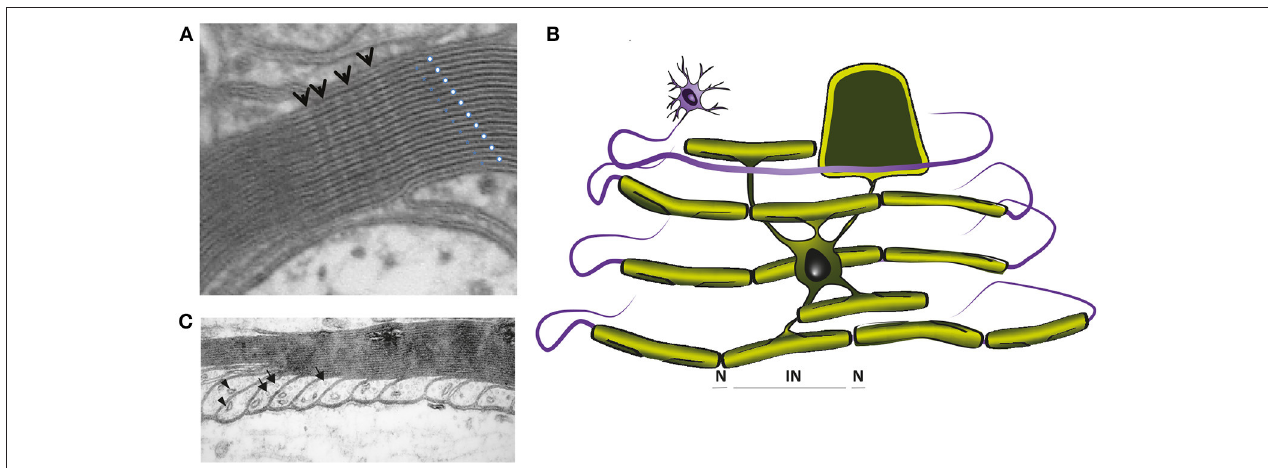
FIGURE 3 | (A) Electron micrograph showing the multilayered myelin sheath of a CNS axon in cross section. Note the regular periodicity of compact myelin, which is composed of the major dense line, reflecting the fused intracellular glial surfaces (white dots), and the 2nm wide intraperiod space between the extracellular surfaces of adjacent wraps (blue dots). Arrows point to radial components. (B) In mature CNS, a single cytoplasmic channel is present around the perimeter of the glial cell process (light green), which is best understood, if the myelin is virtually unwrapped (schematically demonstrated for one internodal segment). The cytoplasmic channel connects the glial cell soma with the most distal part of the myelin sheath and contains organelles and cytoskeletal elements, as shown in C . (C) Electron micrograph of CNS paranodal loops, abutting the axon. These contain microtubules (arrows) and vesicles (arrowheads). ( A,C were reproduced from Edgar and Griffiths, 2013, in Diffusion MRI, From Quantitative Measurement to in vivo Neuroanatomy; published by